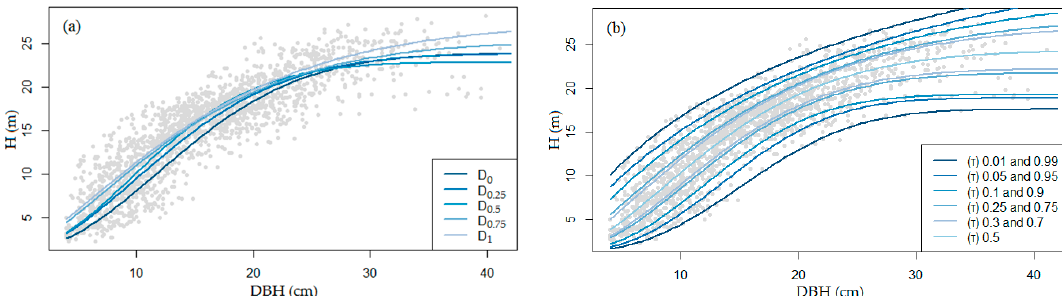
Figure 6. Graphs of observed values (gray dots) and fitted curves (blue gradient lines) generated by the H ‒ D for five competition levels ( a ) and QR models ( b ) based on 11 quantile (0.01, 0.05, 0.1, 0.25, 0.3, 0.5, 0.7, 0.75, 0.9, 0.95 and 0.99 from bottom to top).